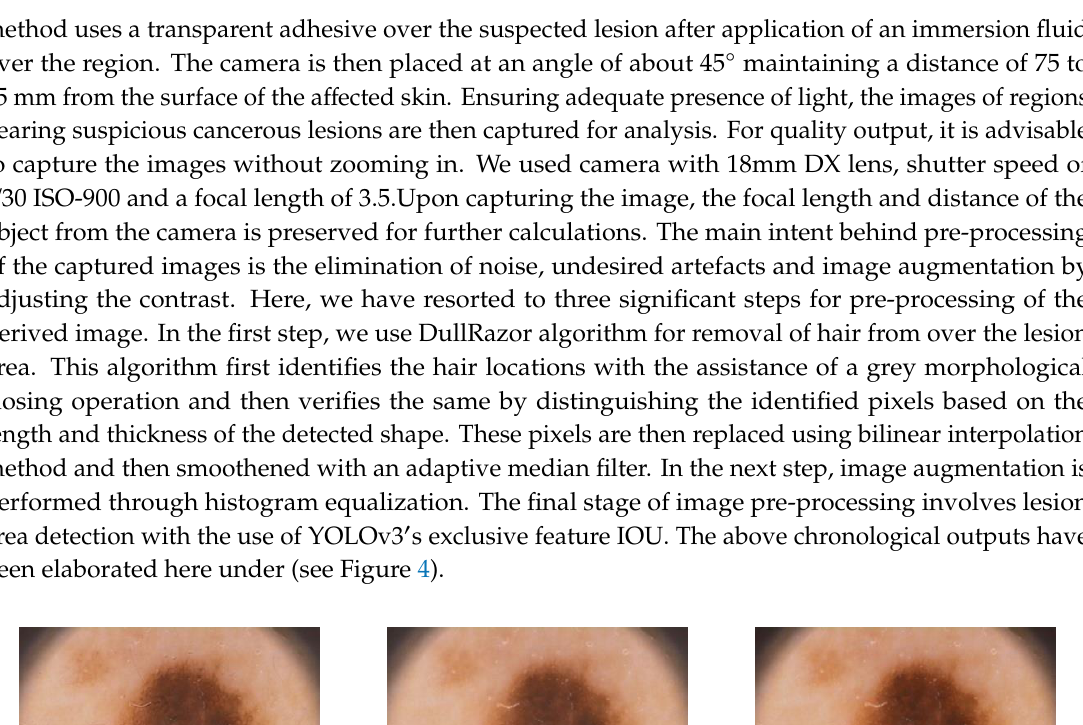
Figure 5. Example of a 4 × 4 sub matrix and its graphical representation . 4.3.1. Iteration-I This phase involves a graph-based model for deriving minimal weight based on threshold value for detection of affected area. To find the minimal weight of the graph we follow the below algorithm: 1. Construct an adjacent matrix. 2. Discard all self loops from the graph and take one minimum edge in place of multi edge expressions. 3. Find one minimum weight from the 1st row and place one connection. In case of a tie, take any one connection arbitrarily. 4. Find one minimum weight from 1st and previously selected vertex row and add it into one. In case of a tie take any one connection arbitrarily, ensuring that it will not form any circuit. 5. Continue this process until all the vertices are covered but does not form any circuit such that it will generate a spanning tree. 6. Then calculate weight